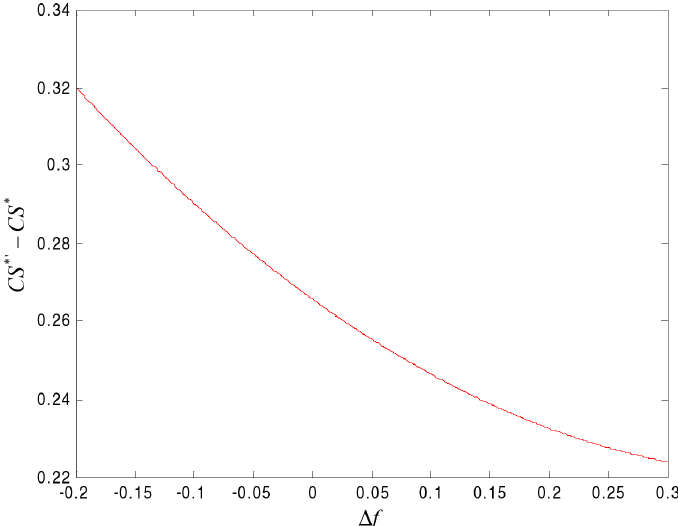
Figure 1. The value of CS * ' – CS * varies with Δ f (if v o = 1 , v c = 1.8 and v p = 2 ).